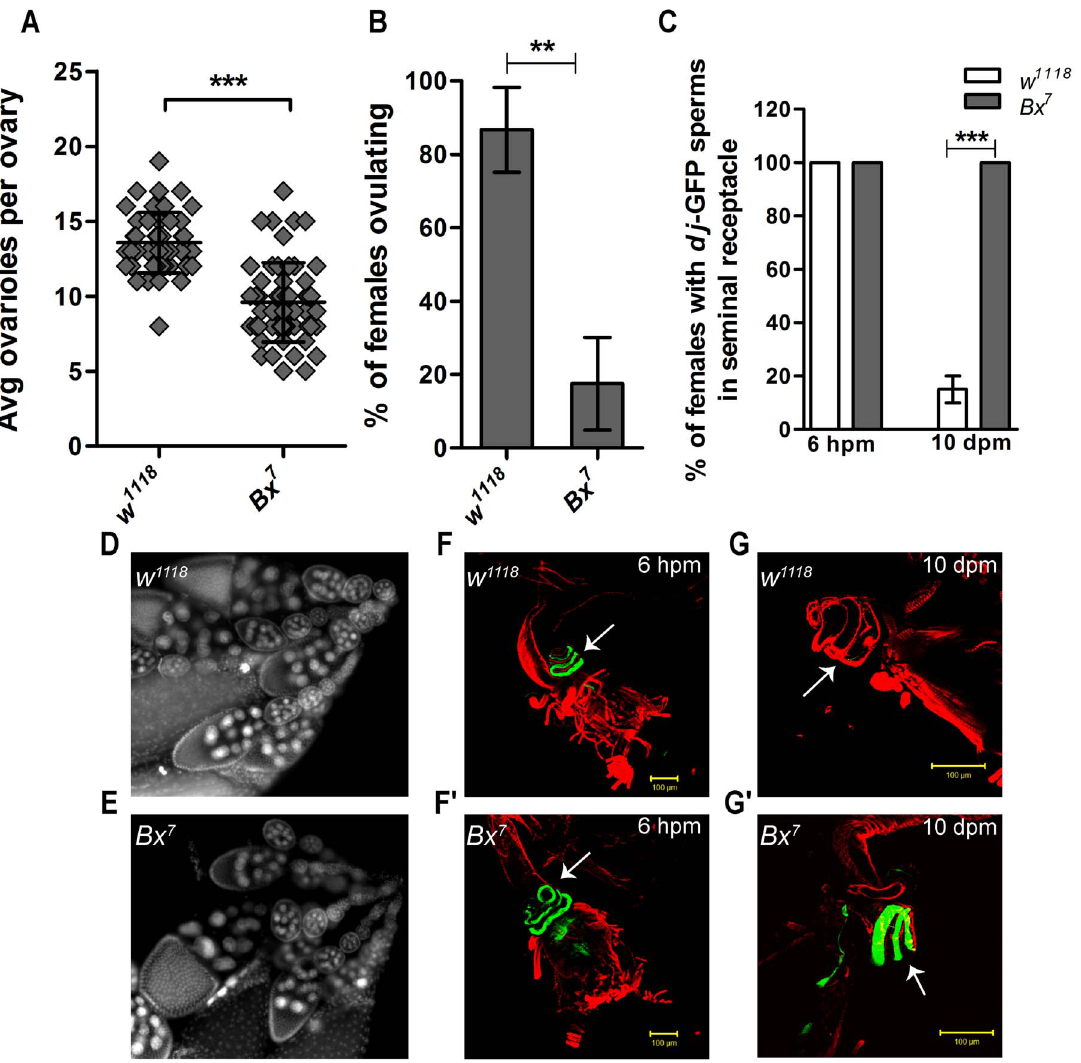
Figure 2. Bx 7 mutant females show normal ovariole development but reduced post mating responses. (A, B) Bx 7 females have reduced number of ovarioles (unpaired t-test, ***, p , 0.0001) and also reduced ovulation (unpaired t-test, **, p=0.0017). (C) Sperm storing and releasing ability of the controls and the Bx 7 mutant females at 6 hpm and 10 dpm respectively (unpaired t-test, ***, p , 0.0001). (D, E) Ovarioles stained for nucleus with Hoechst showed normal developmental stages in the control (D) and Bx 7 (E) females. (F, F’) Bx 7 and the control females, after mating with dj -GFP males, store sperms in the seminal receptacle within 6 hpm. (G, G’) Control flies emptied all the sperms in the seminal receptacle by 10 dpm (G) while Bx 7 females failed to release sperm from the seminal receptacle even after 10 dpm (G’). Green- dj -GFP sperms, Red-Phalloidin-TRITC. assessed for their fecundity and fertility. When Bx was knocked down in the ovarian muscles using Dmef2 -Gal4 (which showed strong expression in all the female reproductive tract muscles) (Figure 3A), neither fecundity nor fertility of the females was affected (Figure 3C and 3D). Elav -Gal4, a pan neuronal Gal4, showed strong expression in neurons innervating more or less all the muscles of the female reproductive tract (Figure 3B and Figure S2). Knock down of Bx in the neurons with Elav -Gal4 led to highly reduced fecundity and fertility which was comparable to the Bx 7 mutant females (Figure 3C and 3D). Even in this case the unhatched eggs were white in color, clearly indicating a defect in the fertilization of the eggs. Knock down of Bx in the neurons not only affected fecundity and fertility, but also phenocopied all the reproductive defects observed in the Bx 7 mutant females like reduced ovulation